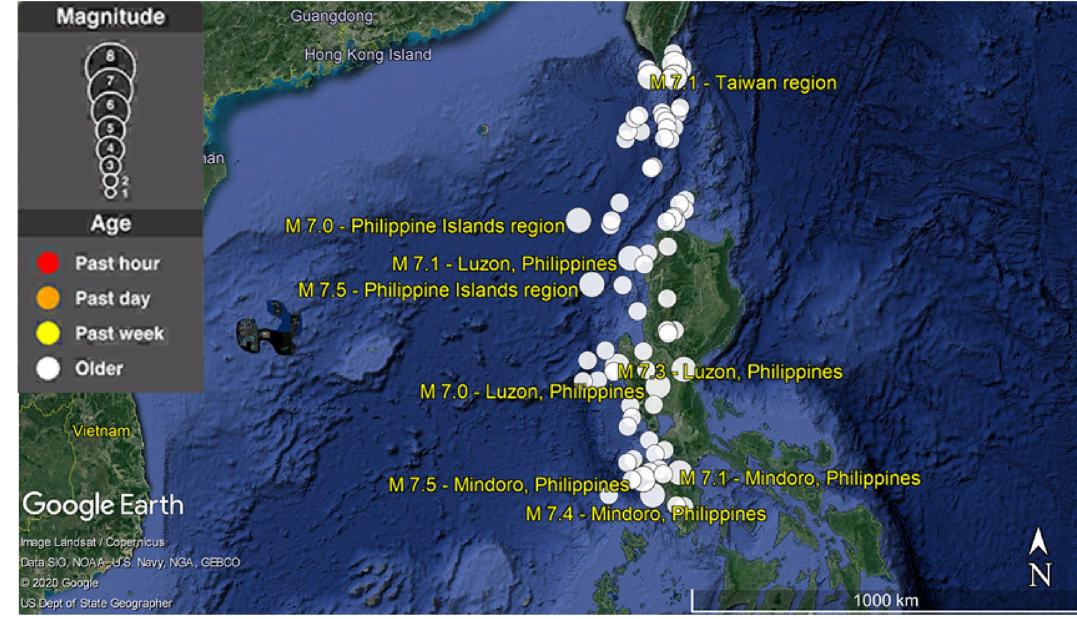
Fig. 1 Past earthquake events occurred at Manila